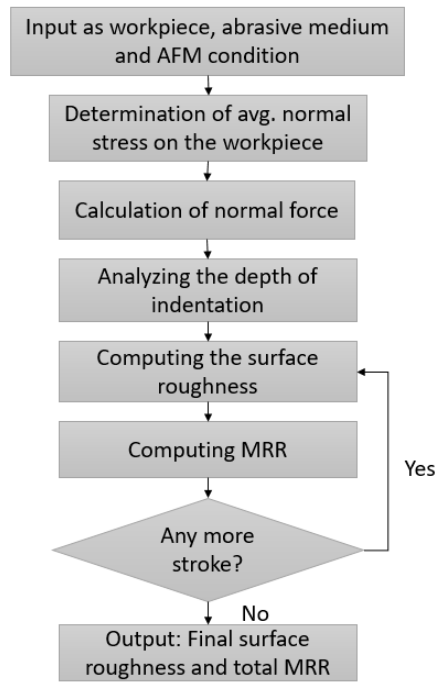
Figure 23. Flow chart of FEM-based Surface roughness and MRR calculation. Zhang et al. have modeled the process of material removal on thermal barrier coatings (TBCs) using the abrasive water jet (AWJ) by new smoothed particle hydrodynamics (SPH)- based model. The results showed that There is good agreement between the analytical model and the erosion rate as the incidence angle increases [160]. Ozcan et al. have Modeled and simulated the controlled depth of abrasive water jet machining (AWJM) of free-form surfaces using the FEM method by signed distance field (SDF) approach. The authors have validated the simulated results from literature and experimental results [161]. Liu et